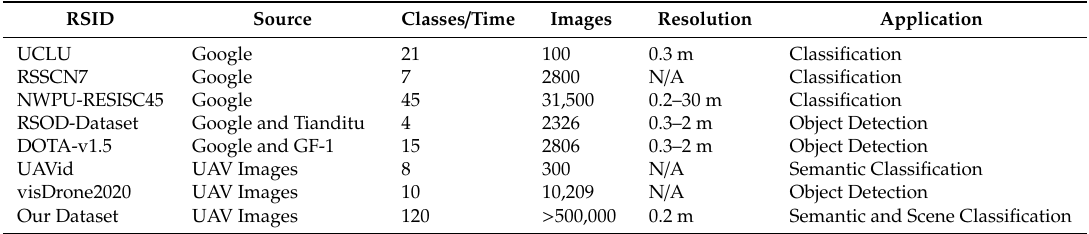
Table 5. The comparison of the typical Remote Sensing Image Dataset